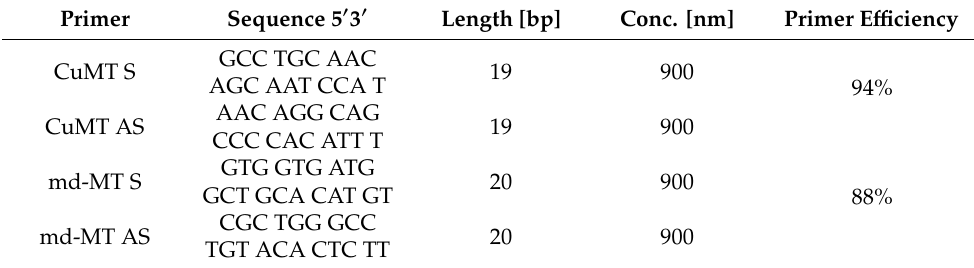
Table 2. Characterization of gene-specific primers used for MT mRNA quantification. Besides the sequence and length of the respective primer, also the primer e ffi ciencies of both primer pairs estimated by generation of a standard curve are reported. Even though the primer e ffi ciency of the second primer pair ( md-MTs ) is below 90%, this combination was used due to length limitation of the respective md-MT mRNA